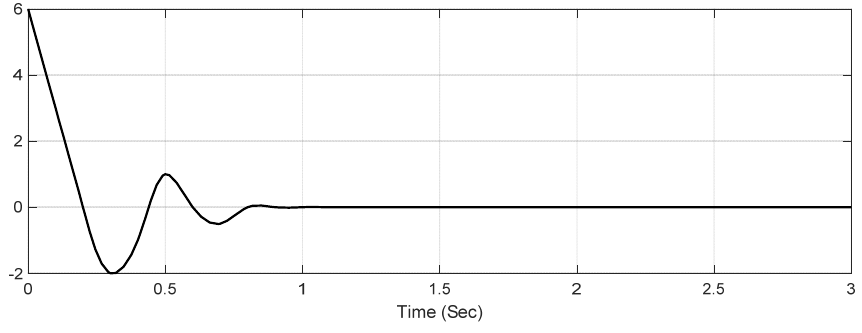
Figure 5. The control signal.